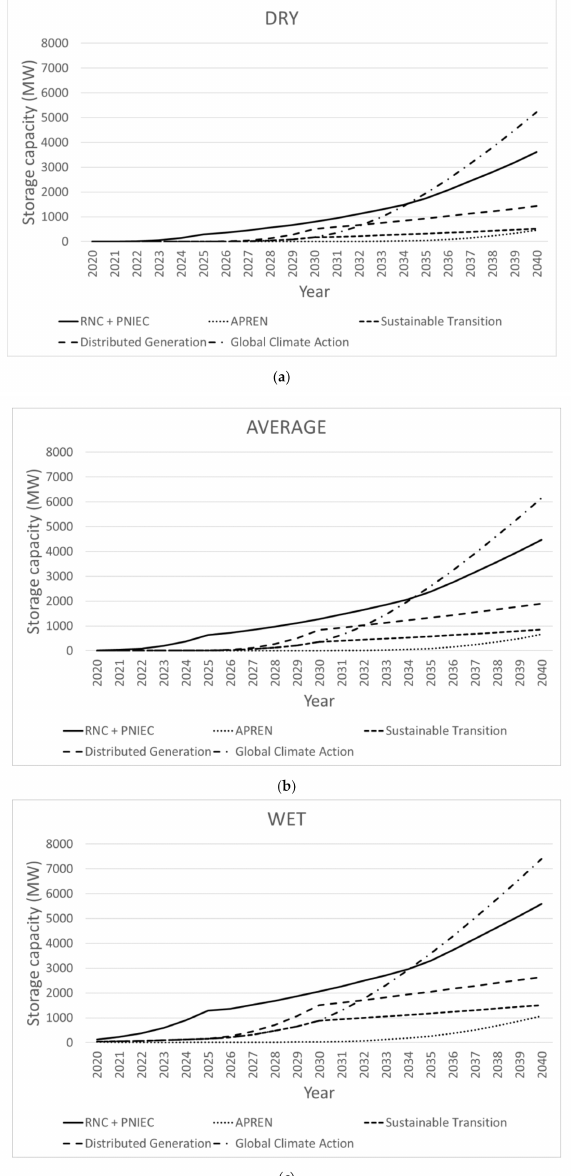
Figure 7. Batteries’ installed capacity for different hydro profiles: ( a ) hydro dry profile; ( b ) hydro average profile; ( c ) hydro wet